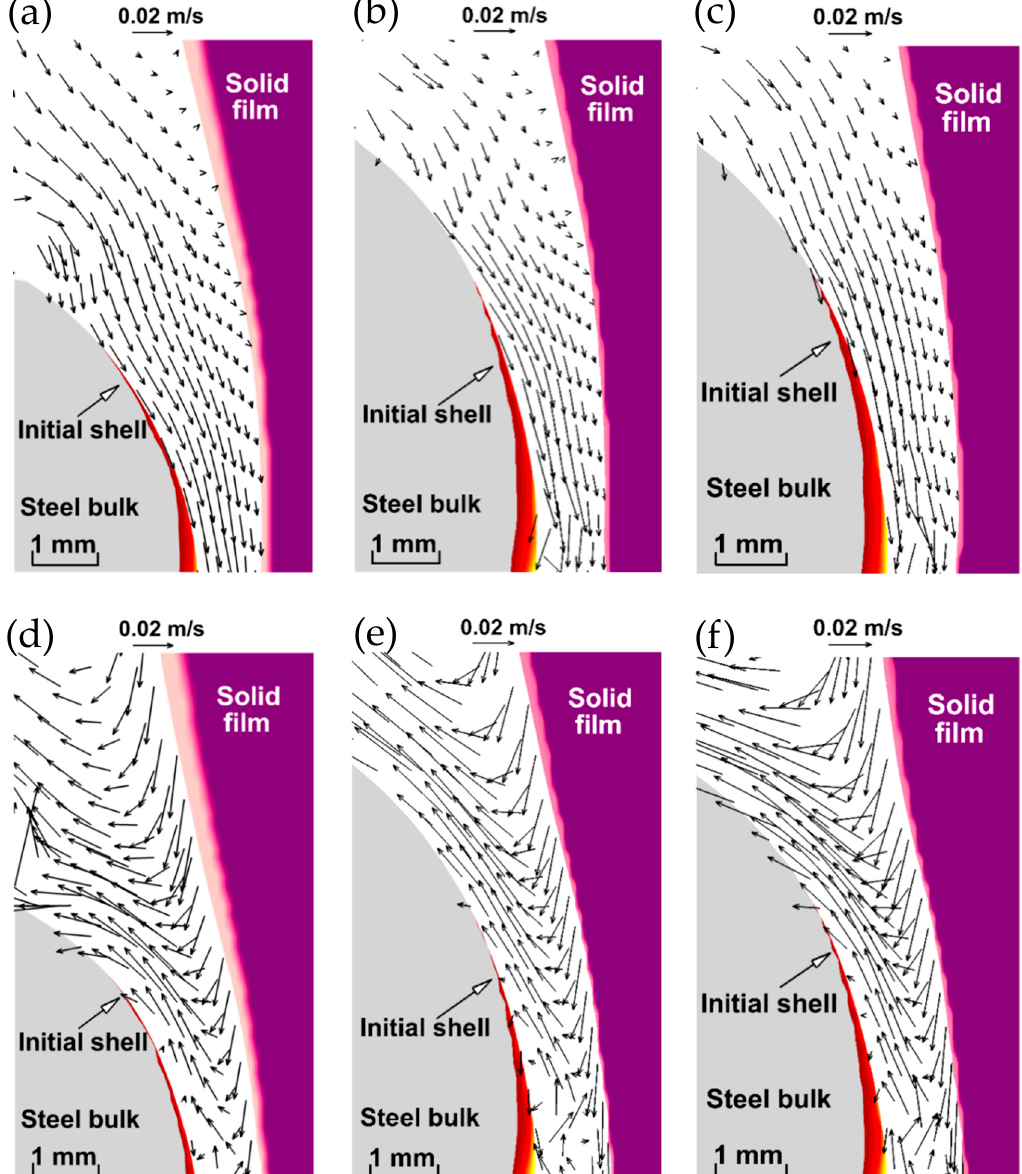
Figure 4. Slag infiltration near the meniscus at different moments for nonsinusoidal oscillation mode: ( a ) t 1 , α = 0.2, ( b ) t 1 , α = 0.5, ( c ) t 1 , α = 0.8, ( d ) t 2 , α = 0.2, ( e ) t 2 , α = 0.5, and ( f ) t 2 , α = 0.8.